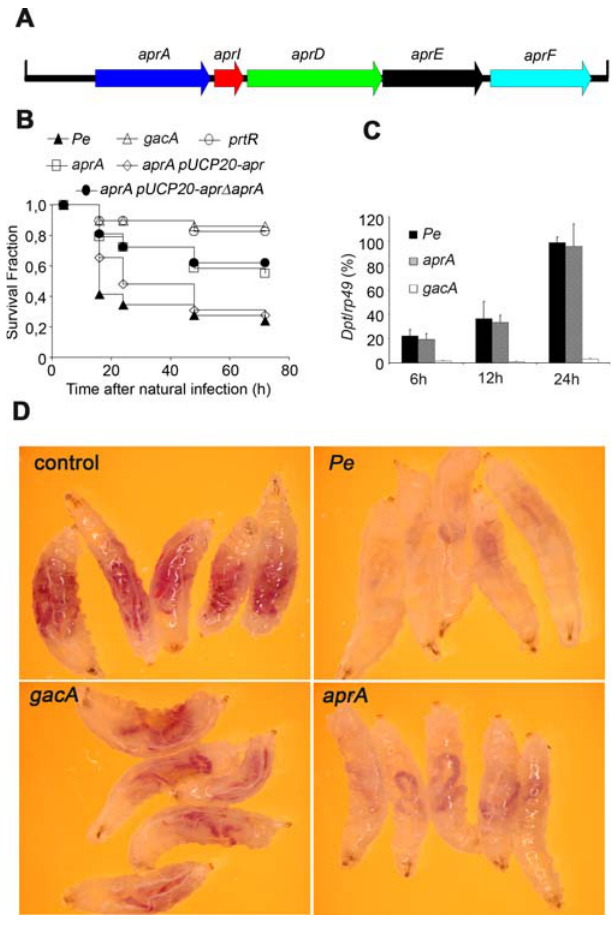
Figure 2. The aprA Mutant Exhibits Attenuated Virulence